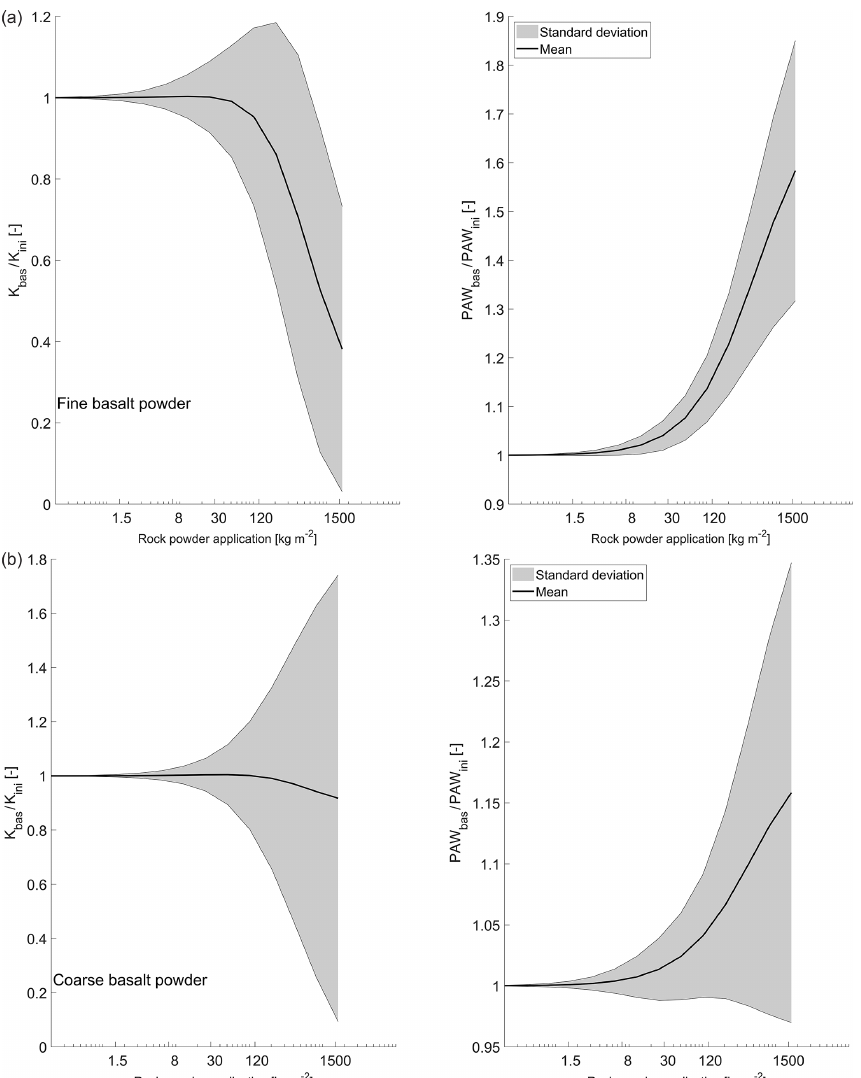
Figure 10. Relative impacts on soil saturated hydraulic conductivity ( K S ) and plant-available water (PAW). K bas and PAW bas , respectively, represent the estimated soil K S and PAW after basalt application. K ini is the estimated initial soil K S , and PAW ini is the estimated initial PAW of different soils. (a) Application of a fine basalt texture (15.6% clay, 83.8% silt, and 0.6% fine sand). (b) Application of a coarse basalt texture (15.6% clay, 53.8% silt, and 30.6% fine sand) for areas corresponding to P gaps of geogenic P supply scenario one, for the N-unlimited AR scenario (Fig. S7a). Mean and standard deviations for n = 15318 grid cells. See Sect. D in the Supplement for impacts of initial K S and PAW of fine or coarse basalt powder texture on soils of P gap areas from Fig. S7c.